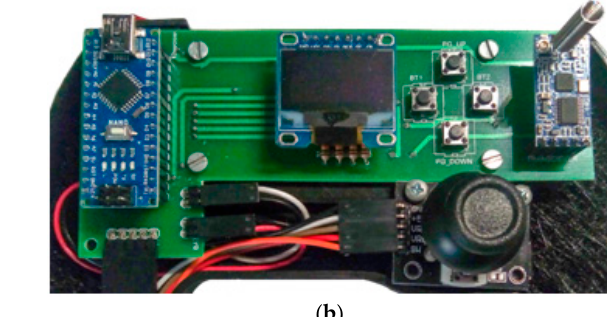
Figure 8. The remote controller: ( a ) the designed and ( b ) the implemented electronic circuit.